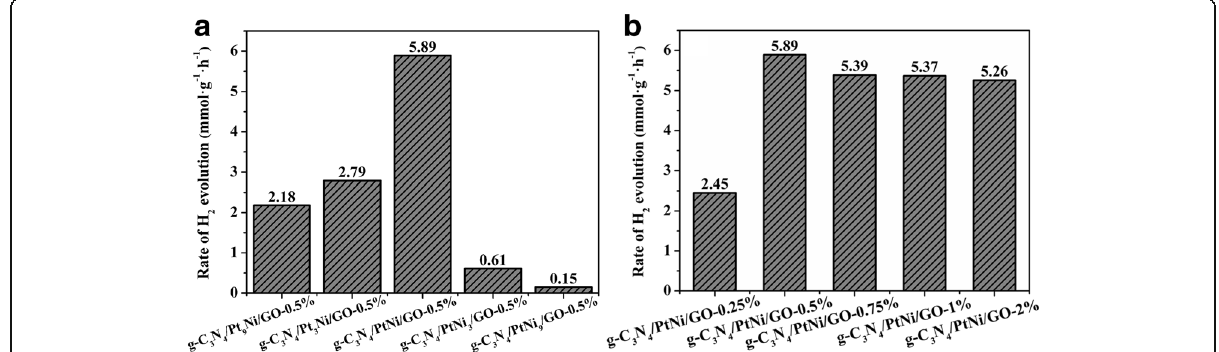
Fig. 5 a H 2 production rate of g-C 3 N 4 /Pt x Ni y /GO-0.5% samples loaded with different Pt/Ni molar ratio. b H 2 production rate of g-C 3 N 4 /PtNi/GO samples loaded with different amounts of PtNi alloy cocatalyst. Light source: 300 W Xenon lamp ( λ > 420 nm). Reaction solution: 100 mL 20%